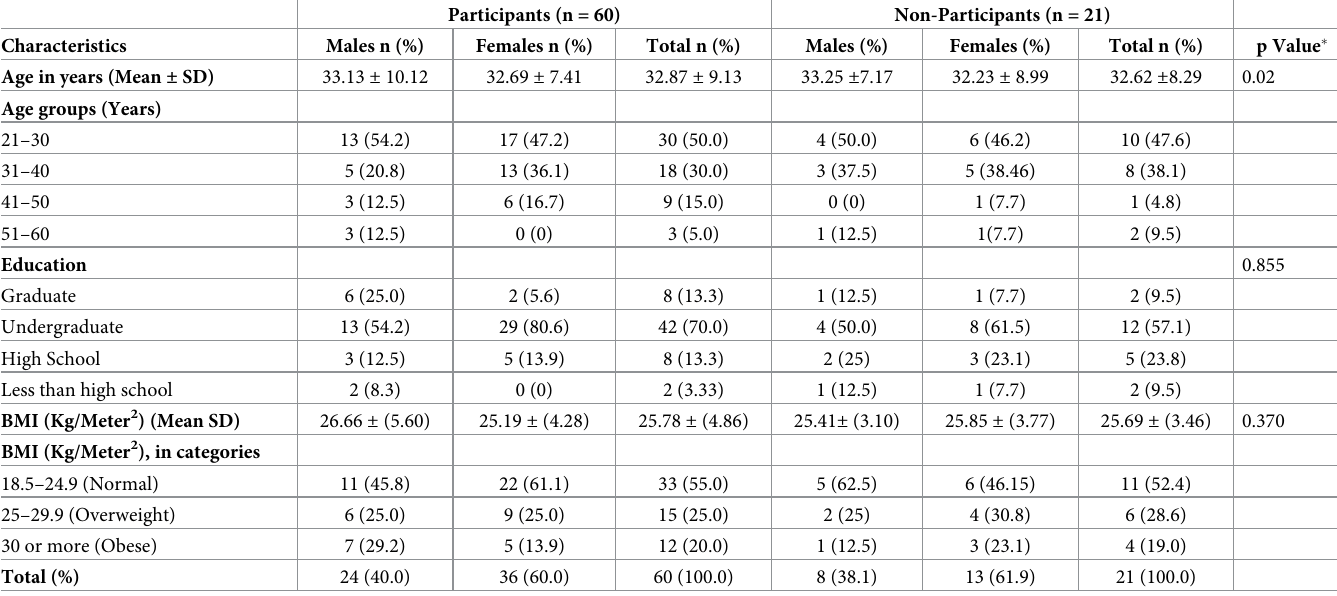
Table 3. Sociodemographic profile of the validation study participants and